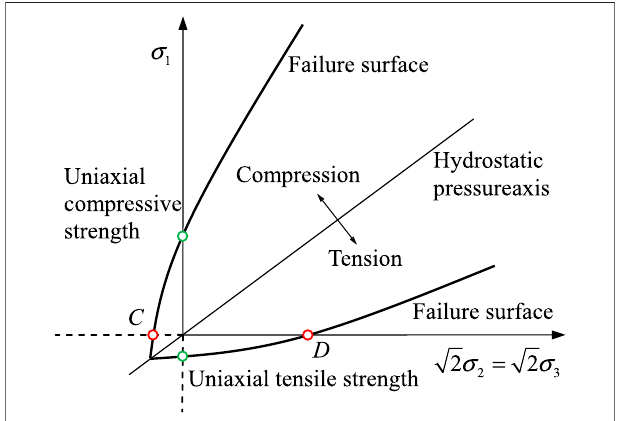
FIGURE 4 | Schematic diagram of failure states in the triaxial plane.